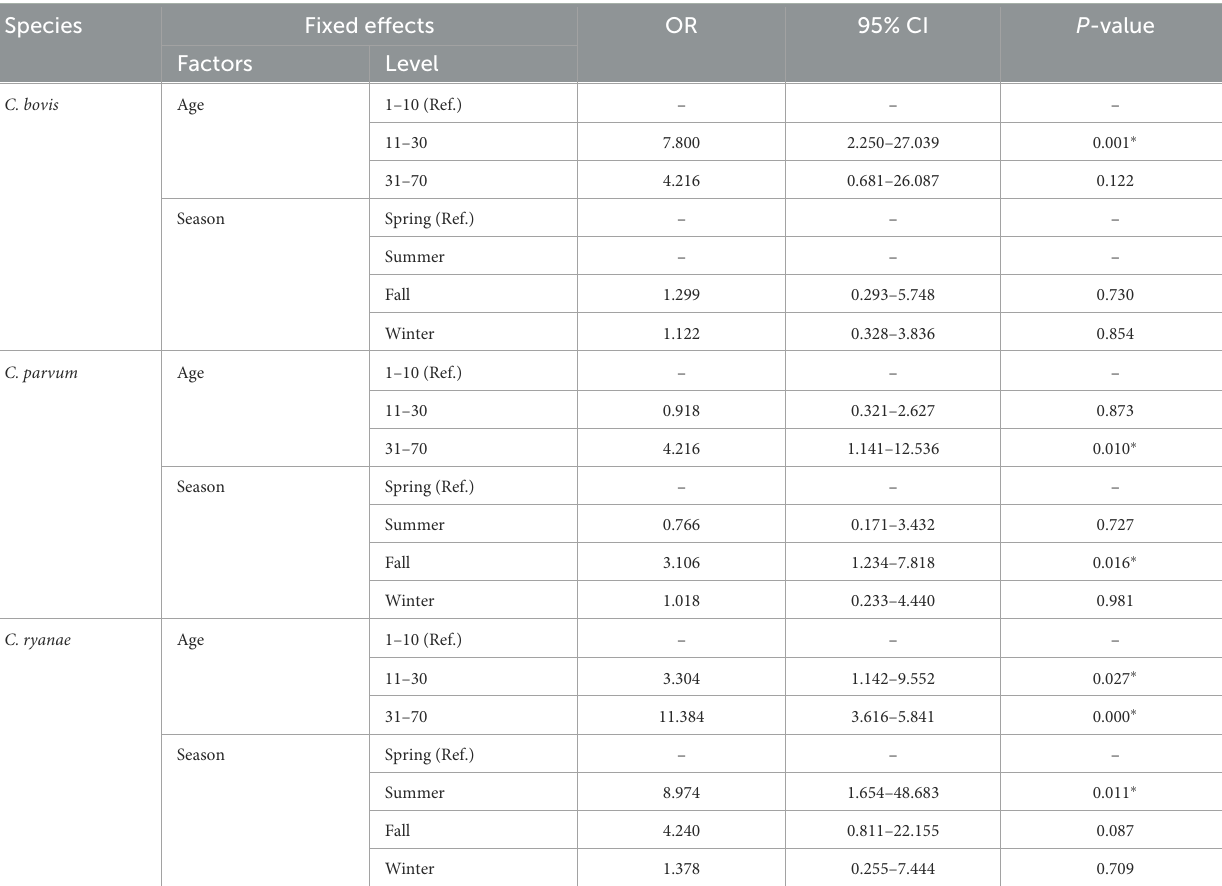
TABLE 3 Generalized linear mixed model results for Cryptosporidium spp. occurrence in pre-weaned calves with diarrhea in the ROK.